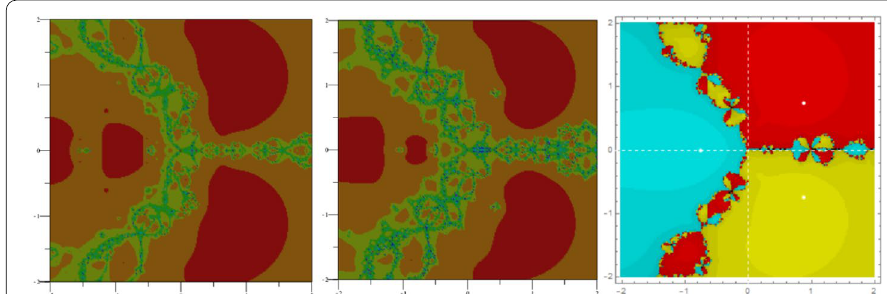
Fig. 8 Plots of 8th BM for θ = 0.5 , θ = 1 and the method in BG [21] respectively for g 3 ( z ) .